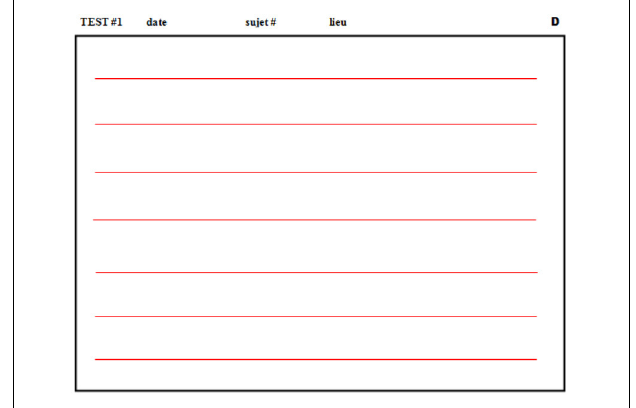
FIGURE 2 | Guiding sheet used to collect handwritten